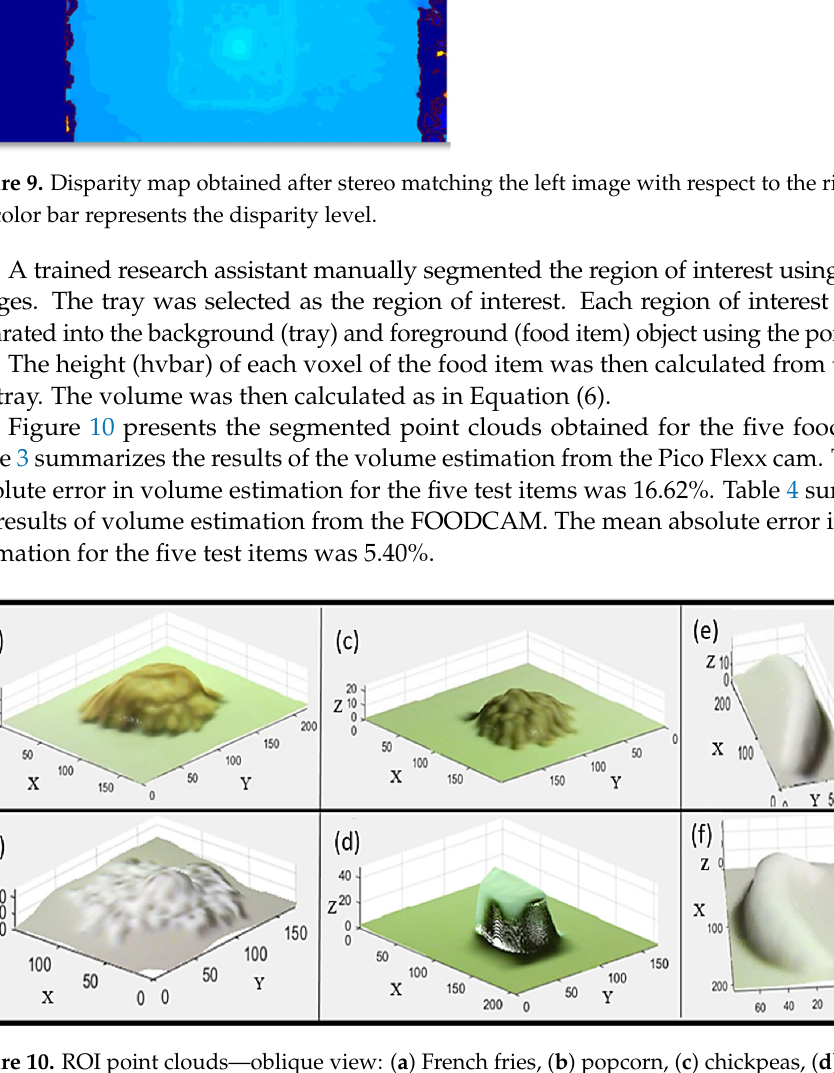
Figure 10. ROI point clouds—oblique view: ( a ) French fries, ( b ) popcorn, ( c ) chickpeas, ( d ) chocolate cake, ( e ) banana (oblique view—1), ( f ) banana (oblique view—2). All units are in mm.